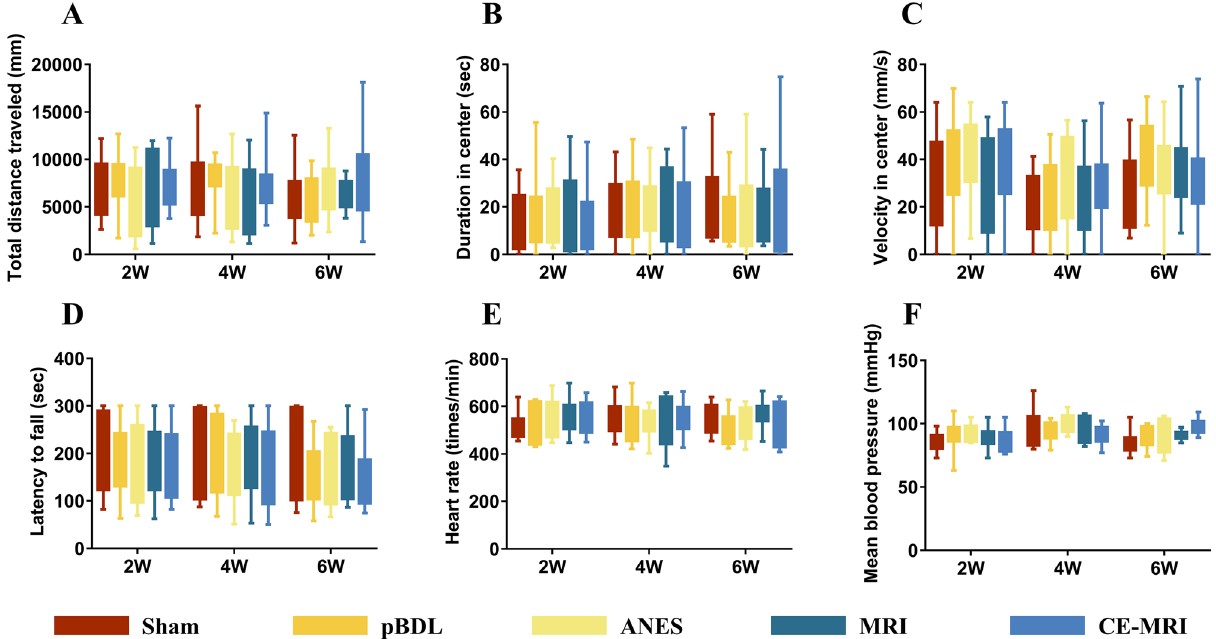
Figure 2. Behavioral and physiological data on weeks 2, 4, and 6 in all groups. ( A – D ) No differences were found in the open-field and rotarod test between the sham group and the remaining experimental groups. ( E ) and ( F ). No obvious changes in the heart rate and mean blood pressure parameters among the different groups. Sham, only suture the abdominal wall. pBDL, partial bile duct ligation surgery alone; ANES, repeated anesthesia in the pBDL model; MRI, repeated magnetic resonance imaging under anesthesia in the pBDL model; CE-MRI, repeated contrast-enhanced magnetic resonance imaging under anesthesia in the pBDL